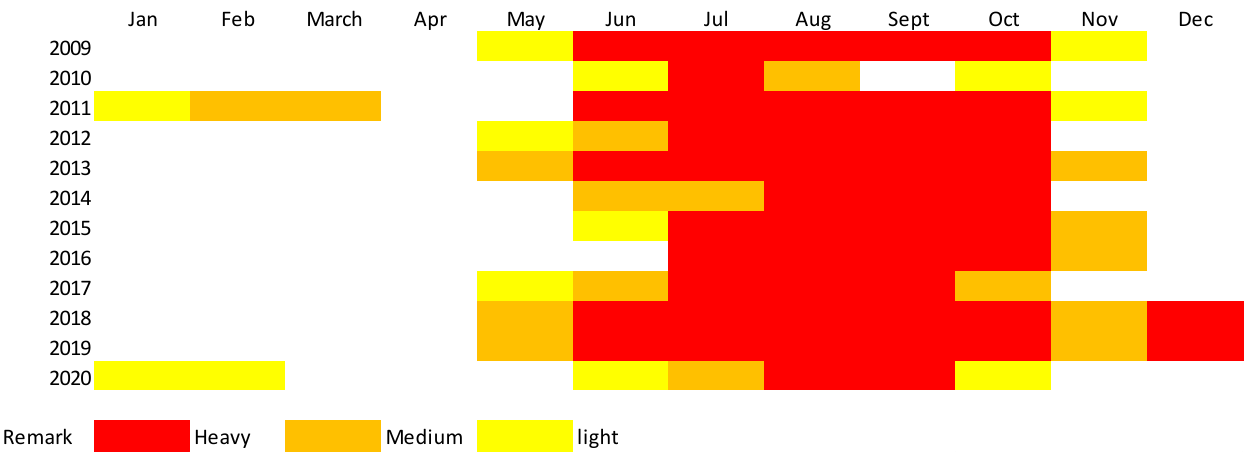
Figure 4. Water balance in the Dodokan watershed from 2009–2020. The examination of the drought index revealed that the drought index value in the Dodokan Watershed during the period 2009–2020 was in the range of 1–118.4. This value is divided into three categories, namely, heavy, medium, and light (Figure 5). Figure 5 shows that the heavy drought index is mostly from June to October, while the light and medium are in May and November. A different pattern occurred in 2018 and 2019, where the drought index in December was included in the heavy category.